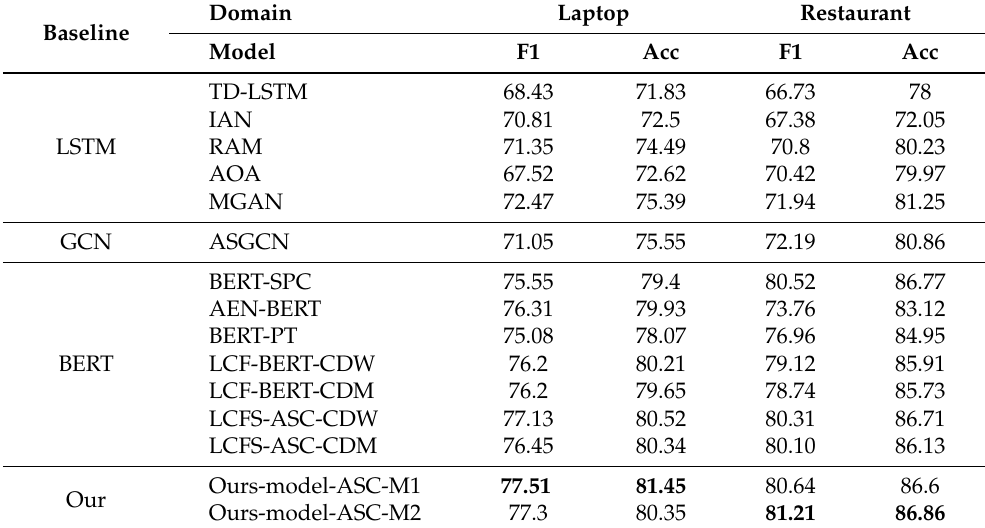
Table 4. Comparison of our ASC model with state-of-the-art methods in terms of accuracy and F1 score (%). Domain Baseline